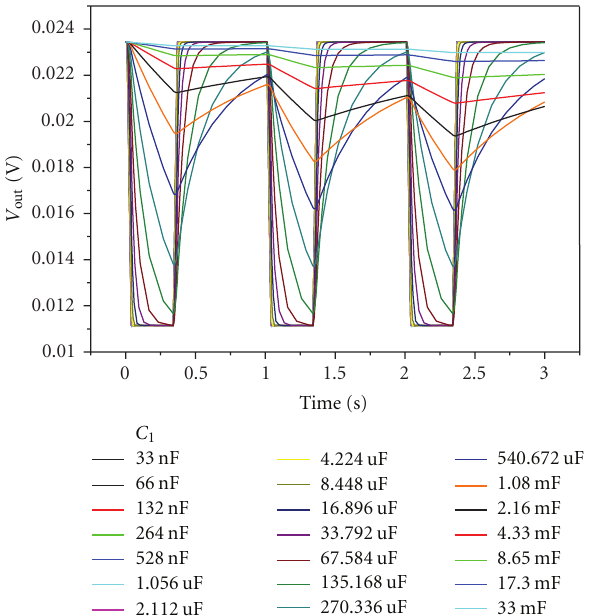
Figure 18: Output data for the pulse parameter for a change of the capacitance of C 1 (33 (nF) ∼ 33 (mF)).